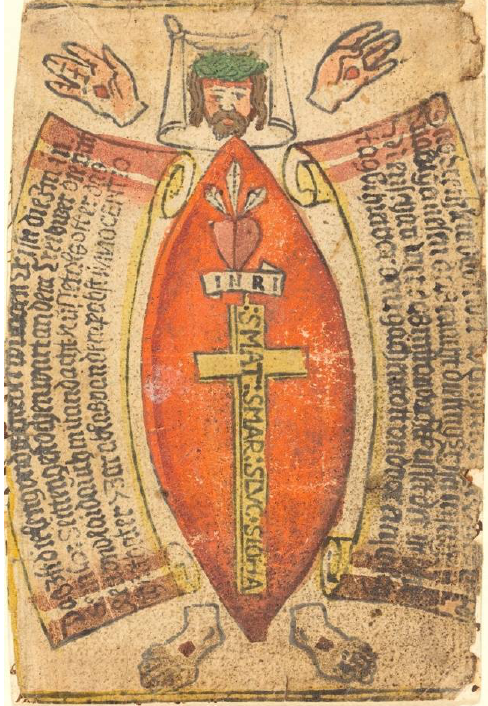
Figure 8. Hand-coloured German woodcut from the 15th century. On left banderole: Das ist die leng vnd weite der wŭnden Cristi die Im in/sein h. Seitten gestochen wart an dem Creitz wer die mit/reŭ vnd laid aŭch mit andacht kŭsset als oft er das/thŭet hat er 7 jar ablas von dem pabst INNOCENTIO). On right banderole: Das Creitzlein das in der wŭnden Cristi stet zu 40/maln gemesen das macht die leng Christi in seiner/Menschait wer das mit andacht kŭsset der ist den/tag behiet vor dem gächen tott vnd vor ein schlag) (trans. in Parshall et al. 2005, p. 259; see also Powell 2012, p. 179ff.). 12 × 8,1 cm. No. 1943.3.831, Rosenwald Collection, National Gallery of Art, Washington. Public Domain.